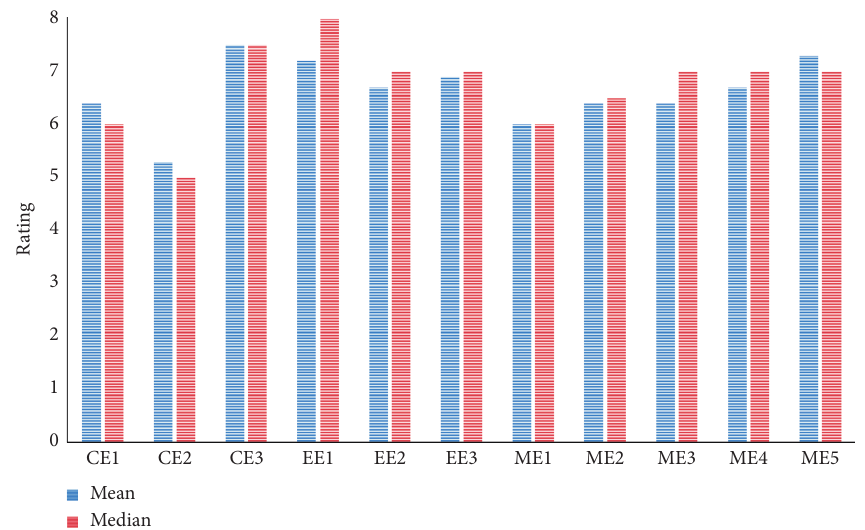
Figure 14: Peer-to-peer rating